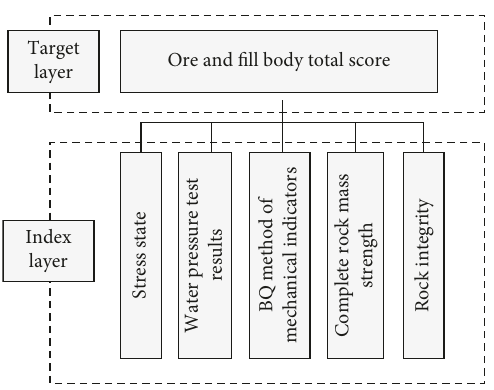
Figure 12: Hierarchical model of the ore body grading and filling. Table 2: Water pressure test